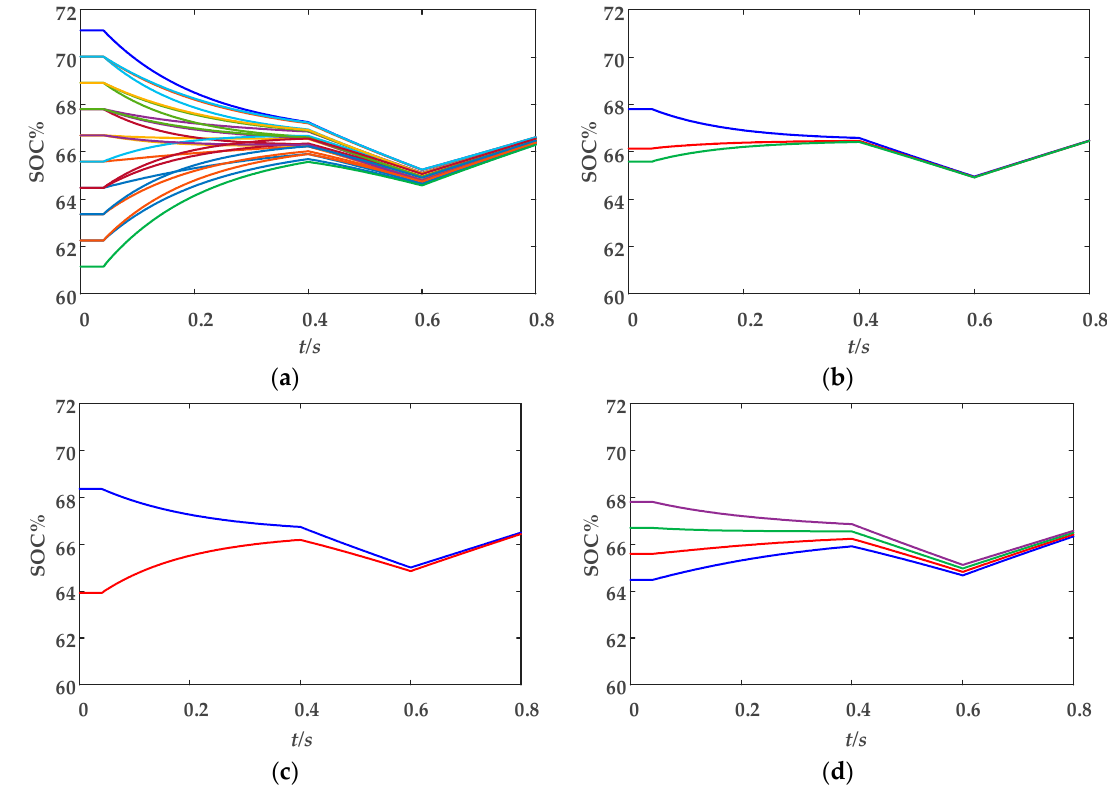
Figure 14. Three-level SOC equalization results. ( a ) SOC equalization of all 24 SMs. ( b ) SOC equalization among three phases. ( c ) SOC equalization between upper and lower arms of phase A. ( d ) SOC equalization among SMs within upper arm of phase A.